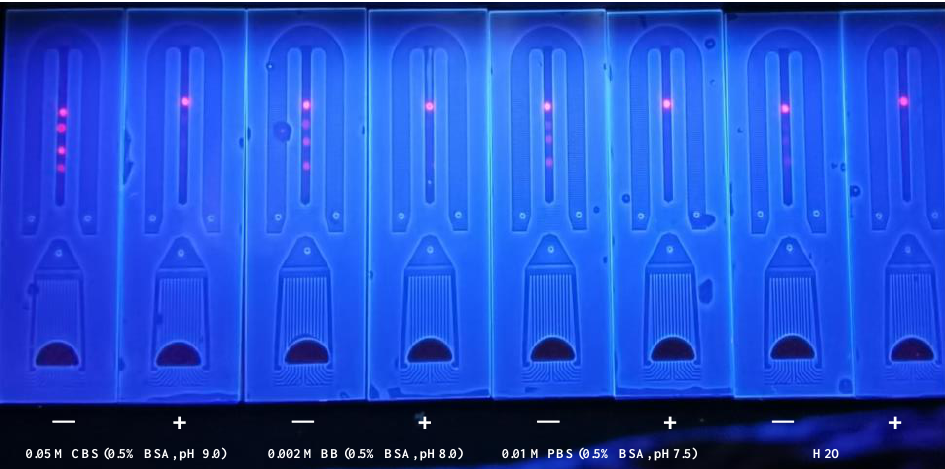
Figure 6. Different buffers for the coating buffer.